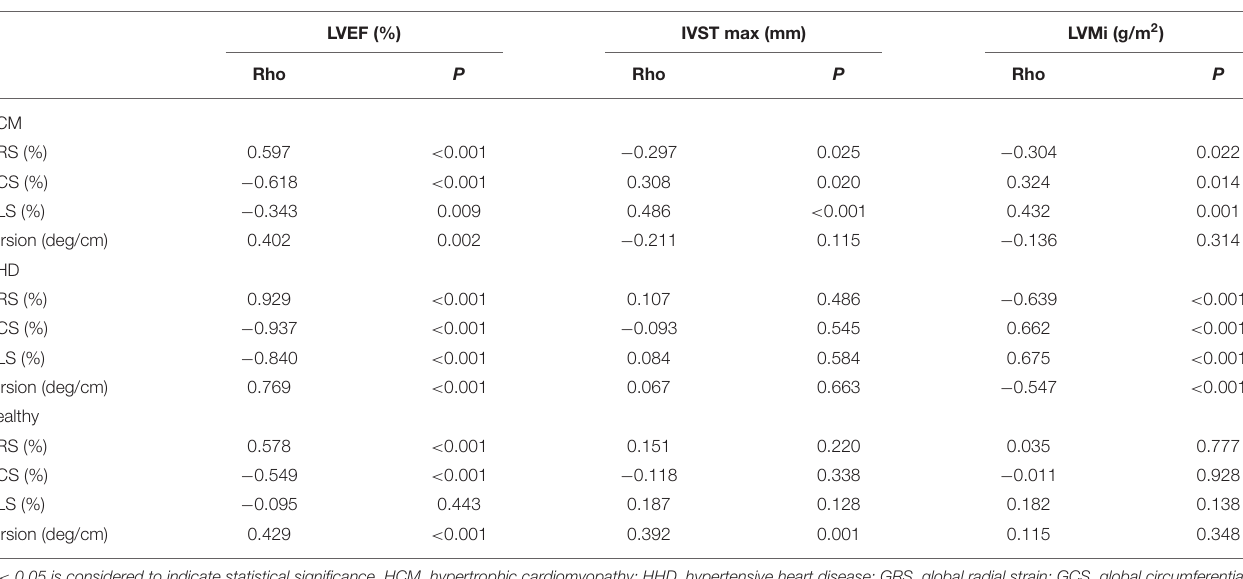
TABLE 3 | Correlations of left ventricular strain with functional and structural parameters.